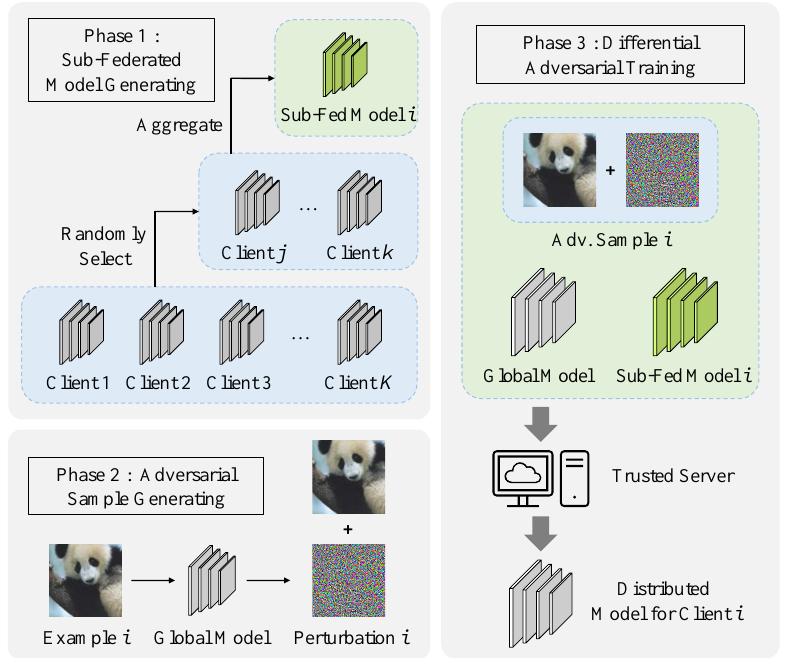
Figure 1. The general working flow of the ARMOR framework. ARMOR consists of three phases: sub-federated model generating, adversarial sample generating and differential adversarial train- ing. The first two phases produce two types of differentiation while the last phase completes the differentiation